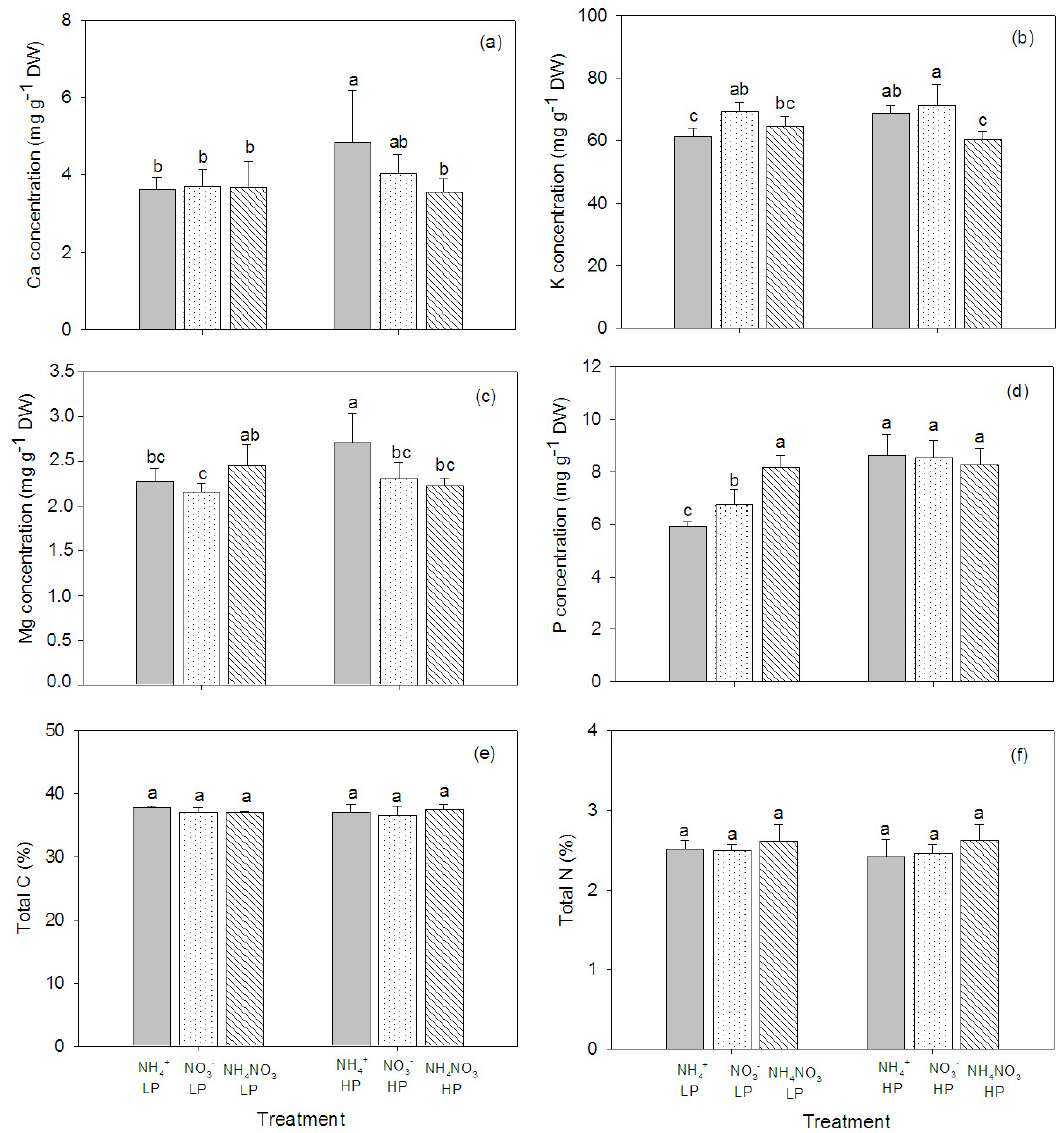
Figure 5. Concentrations of Ca ( a ), K ( b ), Mg ( c ), P ( d ), total C ( e ), and total N ( f ) in leaves of hybrid Napier grass ( Pennisetum purpureum × P. americanum ) (mean ± SD) grown on different N forms (NH 4 + , NO 3 − , and NH 4 NO 3 ) and P concentrations (LP, low P concentration (100 µM P); HP, high P concentration (500 µM P)). Different letters above columns indicate significant differences between treatments.